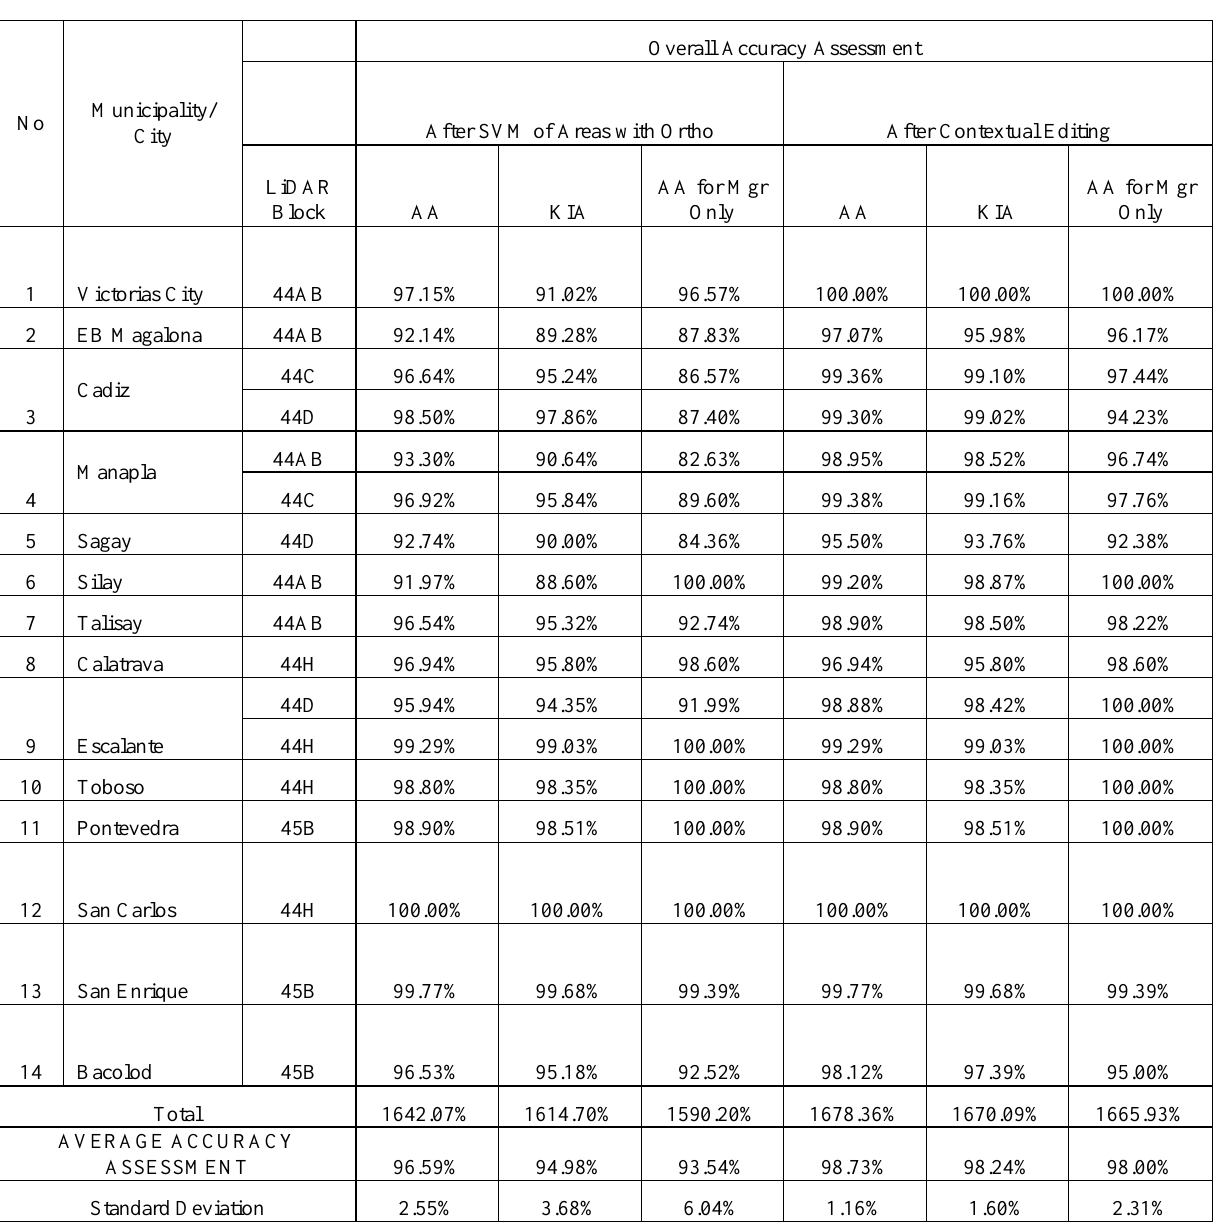
Table 4 Comparative Summary of the Accuracy Assessments of the coastal municipalities/ cities of Negros Occidental with LiDAR